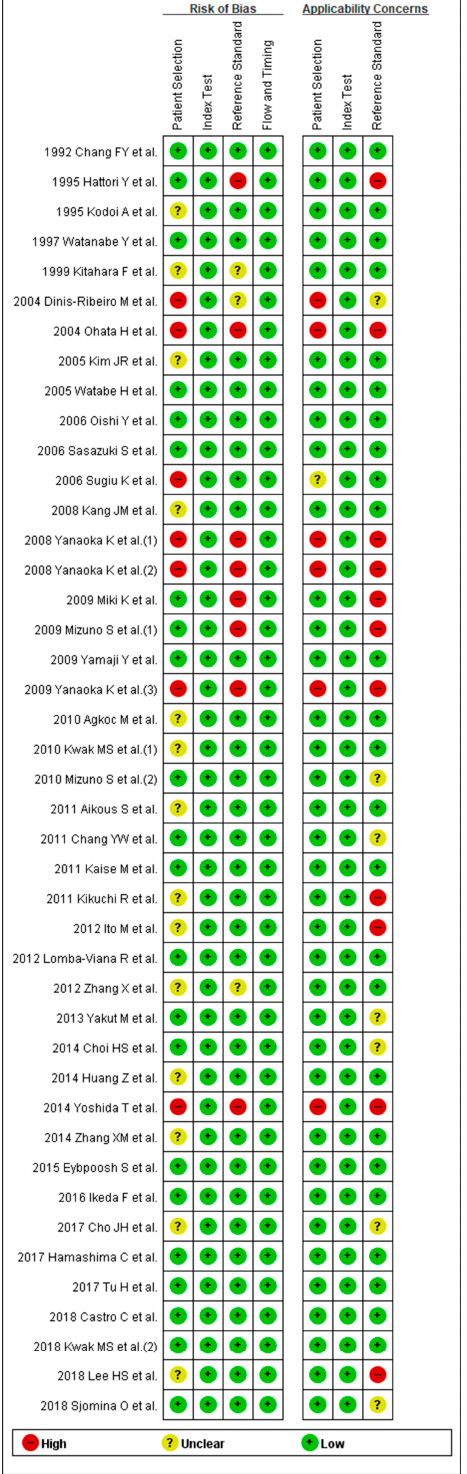
Figure 3. QUADAS-2 for the assessment of the methodological qualities of all the enrolled studies for the diagnosis of gastric neoplasm. ( + ) denotes low risk of bias, (?) denotes unclear risk of bias, (–) denotes high risk of bias. QUADAS-2, Quality Assessment of Diagnostic Accuracy Studies-2.